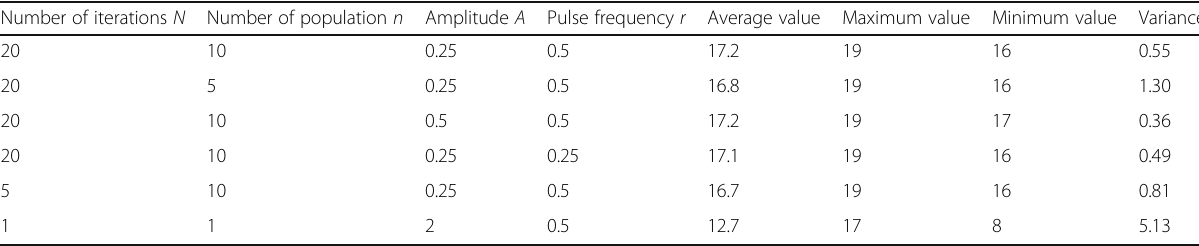
Table 4 The average result of different parameters of the bat